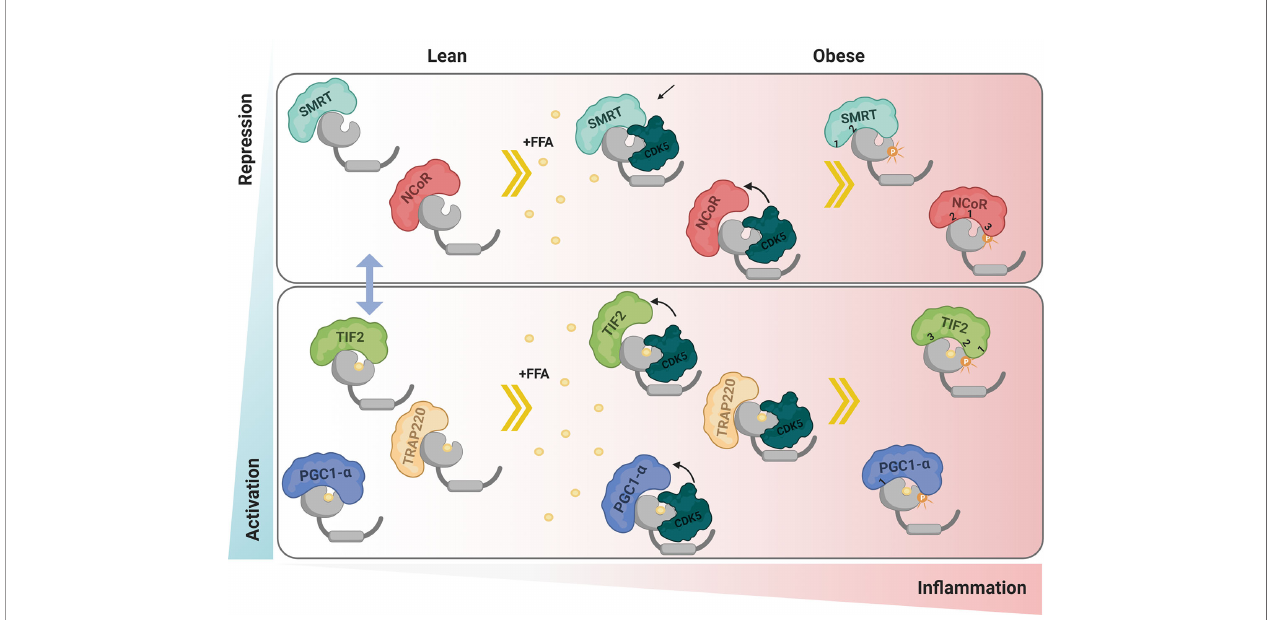
FIGURE 10 | Proposed interaction mechanism. In lean adipose tissue the mechanism of interaction with coactivators and corepressors is in equilibrium, represented by the blue arrow. Under conditions of obesity, free fatty acids and other in fl ammatory factors act by activating the enzyme CDK5 that phosphorylates PPAR g . The presence of CDK5 generates an imbalance in the coregulators homeostasis, increasing the interaction of PPAR g with SMRT while decreasing with NCoR, PGC1- a and TIF2. Ser273 phosphorylation performed by CDK5 also modulates the interaction with coregulators. Both corepressors canonically bind via ID2-H12, and respond to modi fi cation in Ser273, both in the absence and presence of phosphorylation. PGC1- a , although interacting more strongly with the receptor via ID1, showed to make additional contact in a region near Ser273 that is favored in the presence of the ligand. TIF2 binds to H12 via ID3, however ID2 seems to interact better in the absence of phosphorylation and ID1 seems to interact better in the phosphorylation condition. TRAP 220 does not make contact near Ser 273, so it was not responsive to either phosphorylation or the presence of CDK5. Red represents the intensity of in fl ammation in adipose tissue. Blue represents levels of PPAR g activation due to interaction with the coregulators. The numbers 1, 2, and 3 represents the IDs (Created with